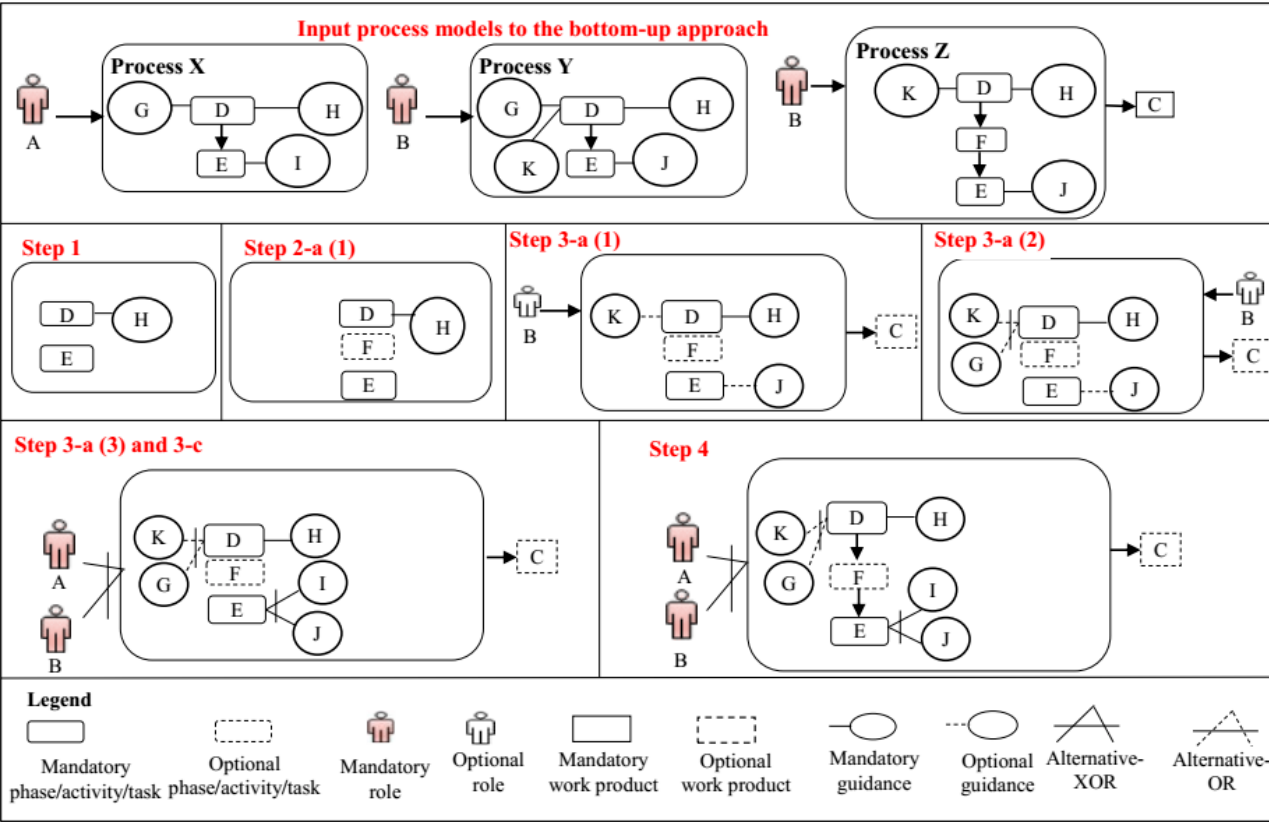
Figure 5. Example of applying the bottom ‐ up approach on three hypothetical processes.